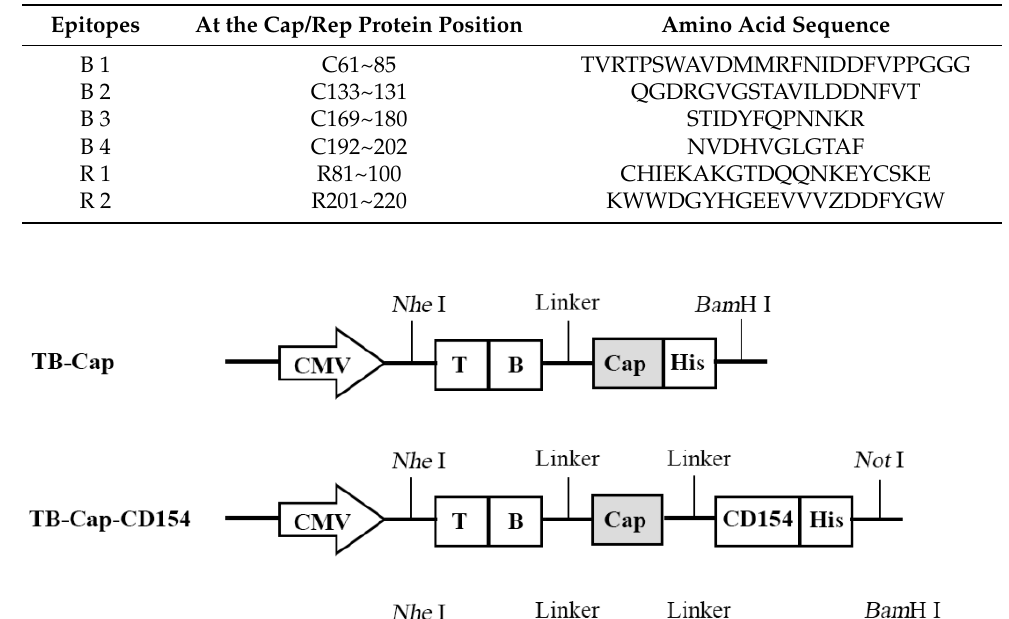
Table 1. B, T cell linear epitopes specific information.